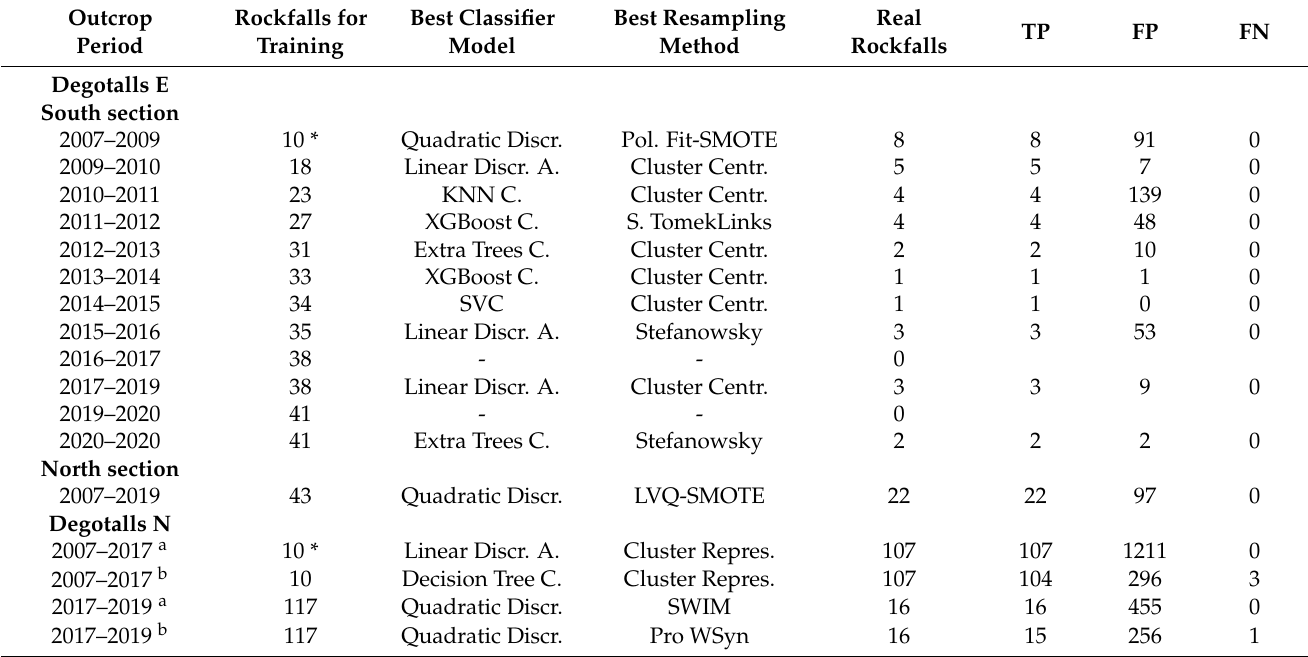
Table 8. Summary of the predictive models results in the Degotalls where the disparity of the best methods is appreciated attending to the true positive (TP), false positive (FP), and false negative (FN) results. Degotalls N presents two solutions: a the best solution with false negatives = 0 or b the best solution, but accepting a reduced number of false negatives. * Initial manual classification. Clusters of “Rockfalls for training” are referred to in the “Candidate” class in the training stage. Real rockfall is referred to existent and known rockfalls on the bedrock.